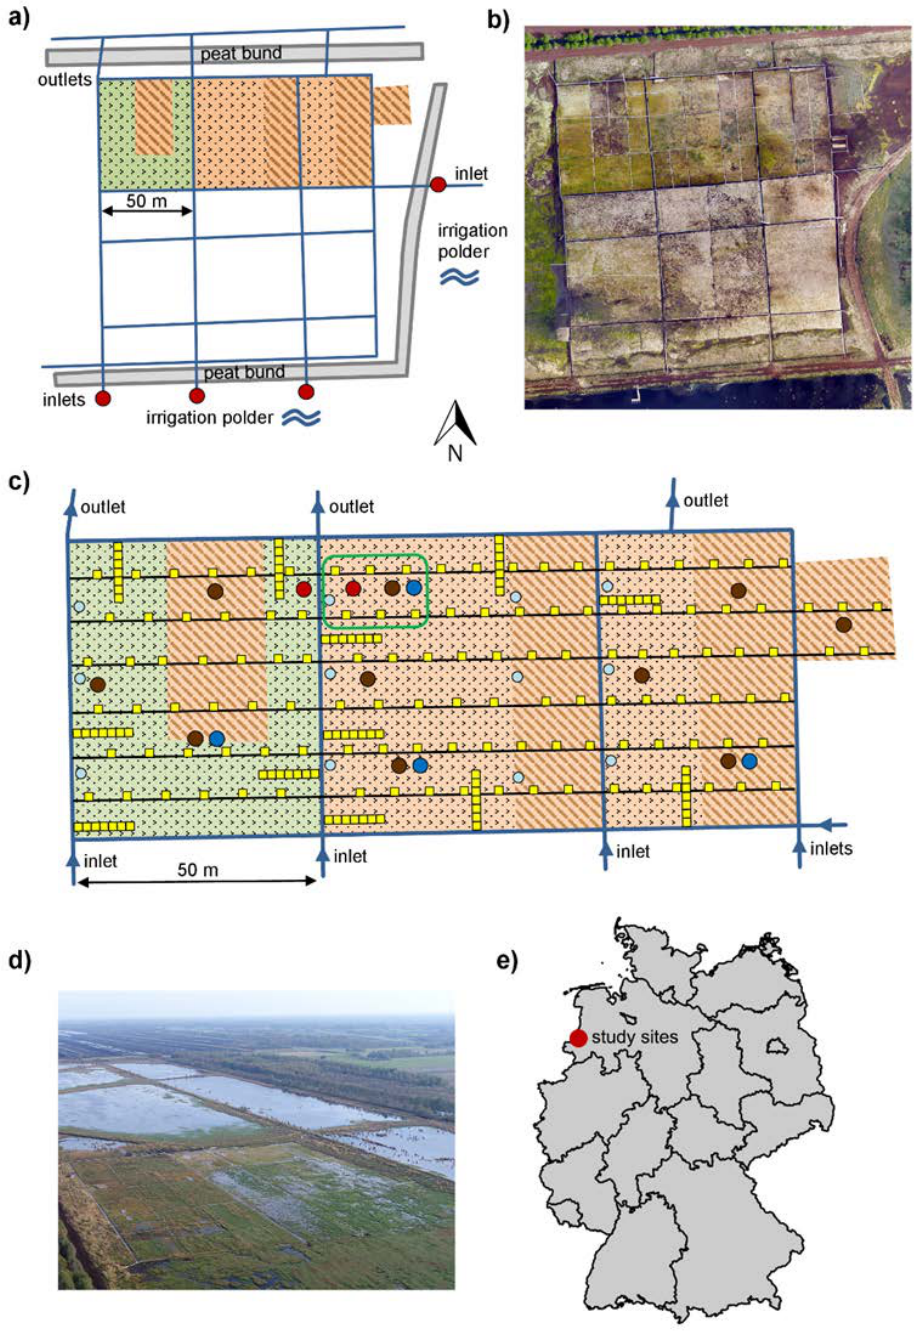
Figure 2. Sphagnum cultivation site “Provinzialmoor”. a) schematic plan with irrigation system; b) aerial view (May 2017); c) study site with sampling locations (vegetation, water, soil, legend see Figure 1); d) cultivation site Provinzialmoor with surrounding rewetted polders (October 2017); e) location of “Drenth” and “Provinzialmoor” near Twist in Lower Saxony (Germany). Photos: Klasmann-Deilmann